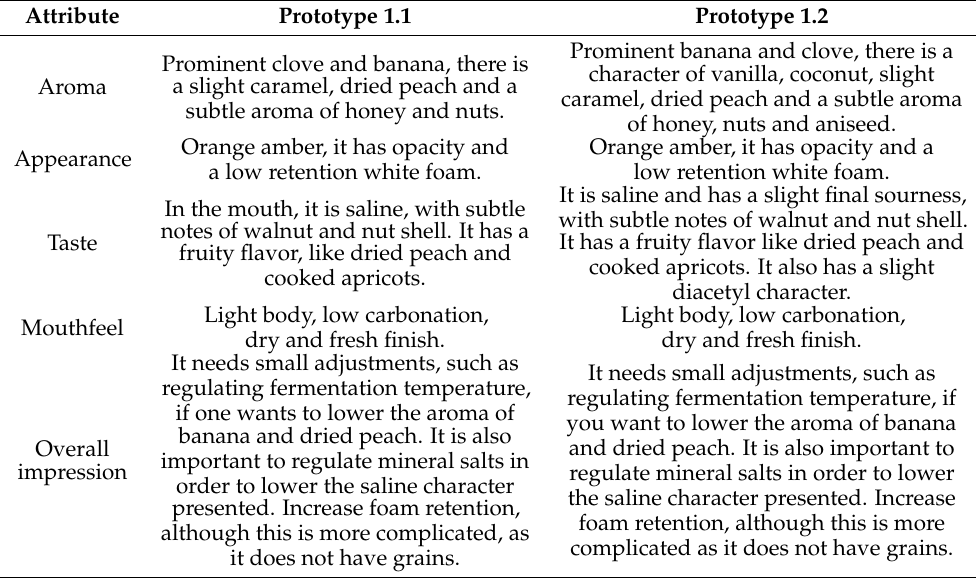
Table 5. Expert sensory analysis of piñon prototype 1.1 and